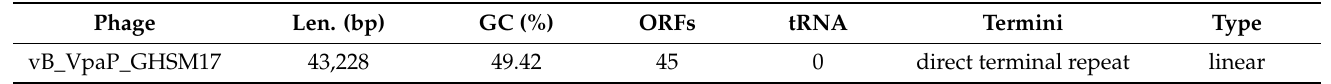
Table 2. Structural characteristics of phage vB_VpaP_GHSM17 genome.